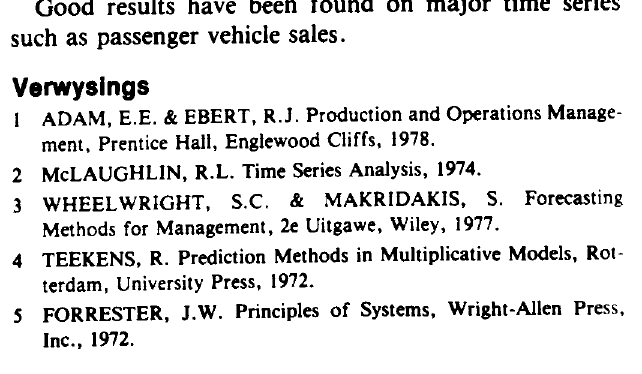
goedgekeur'. Veral draaipunte in die ekonomie word ge reeld verbasend goed vooruit getoon deur die ontleding van Passasiersmotorverkope. Daardie tydsreeks word as deurlopende eksperimentele tydreeks gereeld ses-maande liks op datum gebring by